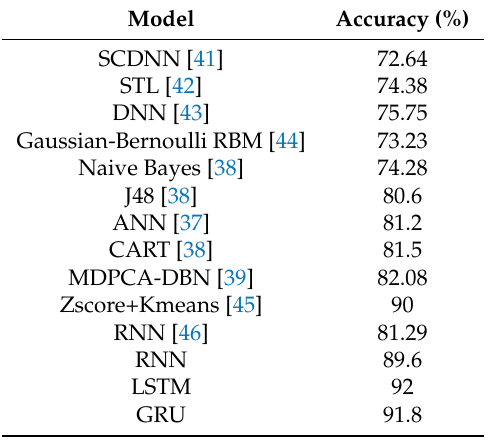
Table 8. Comparison accuracy detection results on NSL-KDD dataset